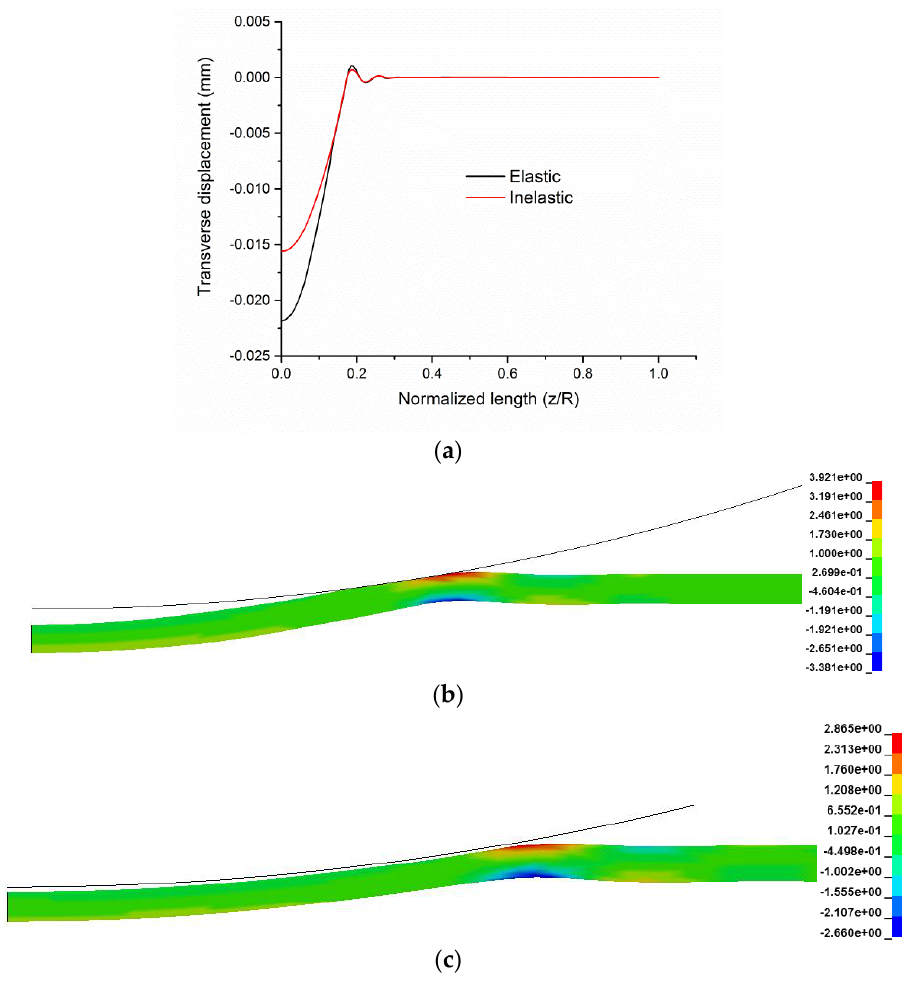
Figure 4. Cylindrical projectile impact at V = 200 m/s at 0.0784 µs: ( a ) transverse displacement, axial stress contours in GPa; ( b ) elastic; and ( c ) inelastic.